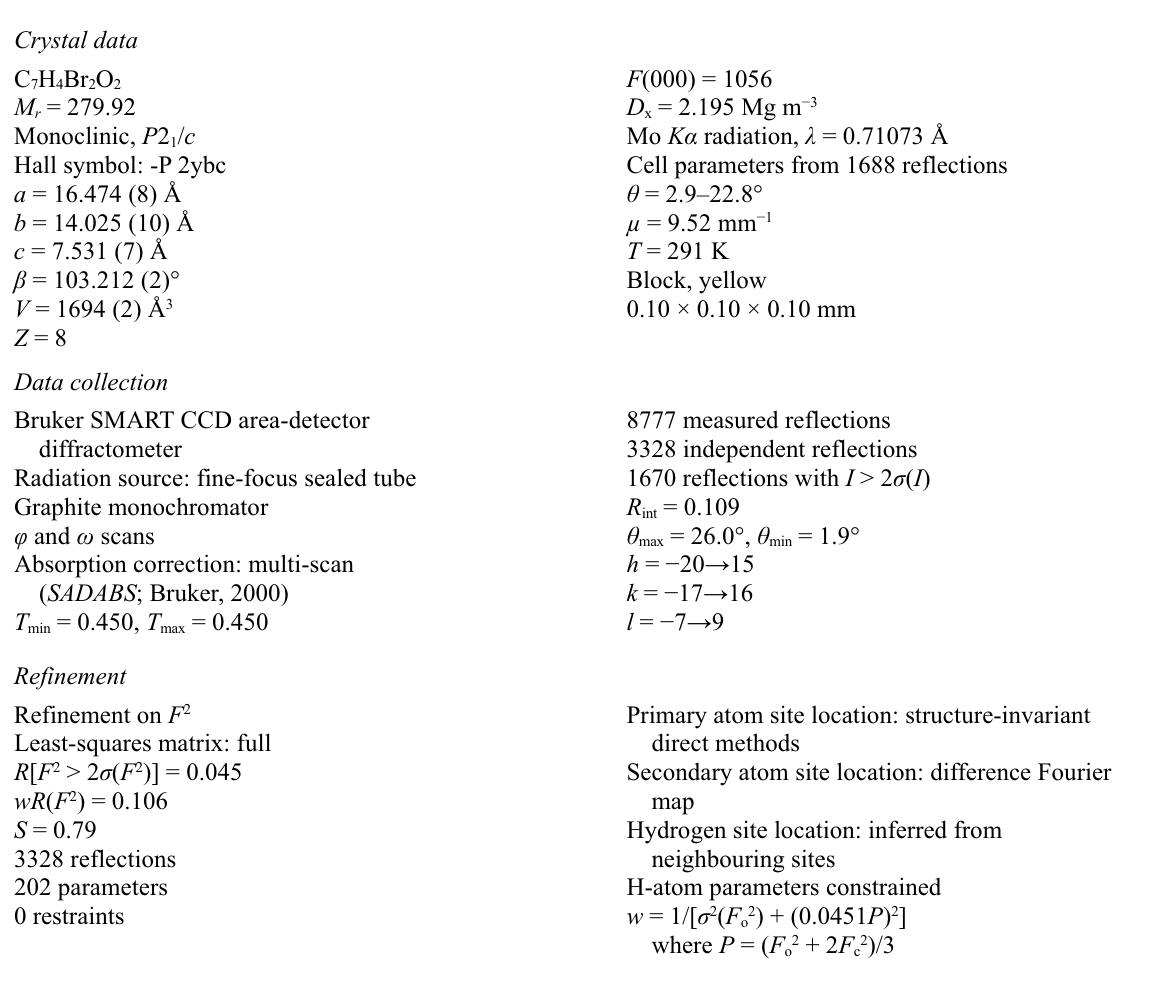
Figure 3 A perspective view of the interlayer π – π stacking interactions together with the centroid–centroid contacts.